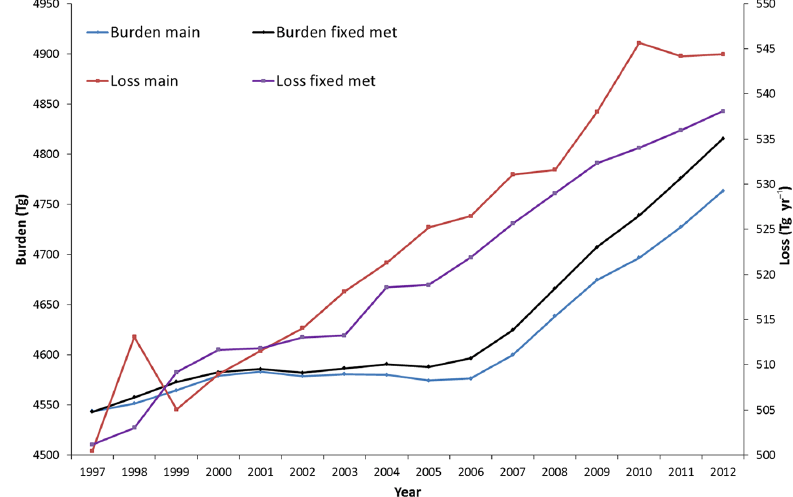
Figure 3. Atmospheric CH 4 burden and atmospheric chemical loss for the simulation with “fixed meteorology” and the “main” simulation.